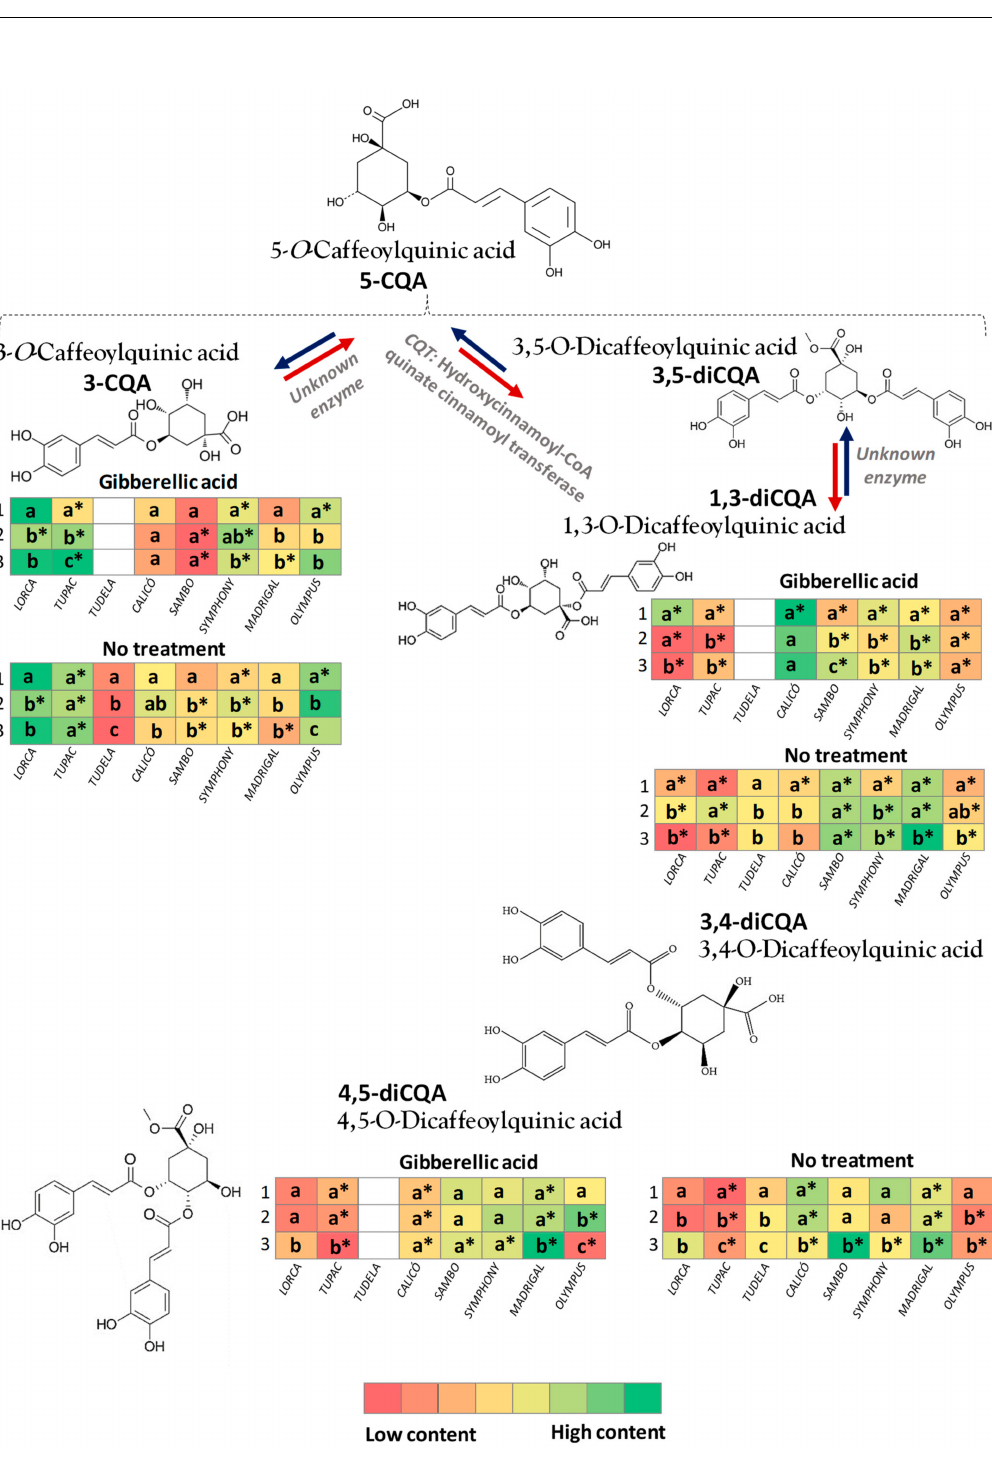
Figure 5. The 3- O -caffeoylquinnic acid (3-CQA), 1,3-di- O -caffeoylquinnic acid (1,3-diCQA), and 4,5-di- O -caffeoylquinnic acid (4,5-diCQA) content (mg · kg − 1 ) of globe artichoke cultivars influenced by flower head order (main, secondary, and tertiary heads represented in the heatmap with numbers 1, 2, and 3) and treatment (gibberellic acid or no treatment). The heatmap shows the biosynthesis pathway of the three minor hydroxycinnamic acids from the major ones analysed. Data are the mean ± SE. Colours in the diagram represent the low or high content, ranging from red to green, respectively. Different letters within the same column show significant differences ( p < 0.05 according to HSD Duncan’s test) among flower head orders for each artichoke cultivar and treatment. Significant differences between both treatments ( p < 0.05 according to Student’s t -test) were expressed as * placed in each block for each artichoke cultivar and flower head order. On the other hand, 1,3-diCQA is derived from 3,5-diCQA by an unknown enzyme. Most of the cultivars studied, ‘Lorca’, ‘Tupac’, ‘Sambo’, ‘Symphony’, ‘Madrigal’,